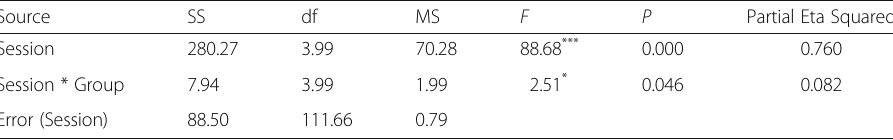
Table 7 The result of repeated measure ANOVA in the intensity level of the 10 sessions Source SS df MS F P Partial Eta Squared Session 280.27